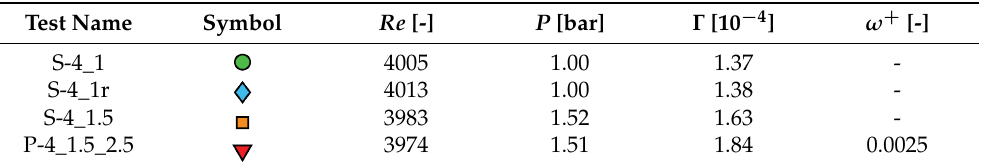
Table 2. Provides a summary of all experimental conditions for filtration tests. The columns indicate: the Reynolds number, Re = Uh/ ν , the pressure, P , the suction coefficient, Γ = v/U and the non- dimensional frequency, ω + = 2 π f ν / u*